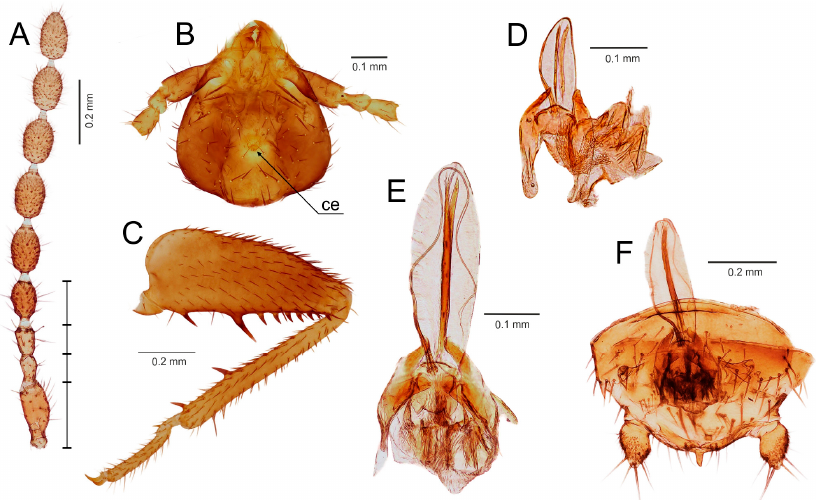
Figure 4. Morphological characters of Spiralizoridae: Latinozorinae. ( A ) right antenna of Latinozoros sp. 1 with lengths of the three basal antennomeres indicated, male, Dominican Republic; ( B ) dorsal view of head of Latinozoros sp. 1, male, Dominican Republic; ce - cephalic gland; ( C ) right hind leg of Latinozoros sp. 1, male, Dominican Republic; ( D ) male genitalia of Latinozoros sp. 2, latero-ventral view, French Guiana; ( E ) male genitalia of Latinozoros sp. 1, ventral view, Dominican Republic; ( F ) abdomen end of Latinozoros sp. 1, male, Dominican Republic.